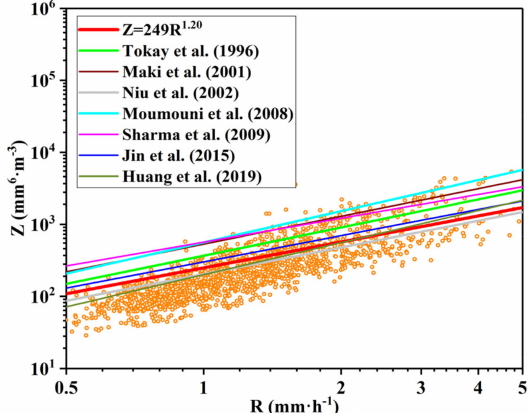
Figure 7. Scatterplots of Z versus R and the fitted relationship for stratiform rainfall. The red curve is the fitted curve for stratiform precipitation in Xinjiang, and the orange circles represent the scattered points of the Z–R relationship obtained from the disdrometer